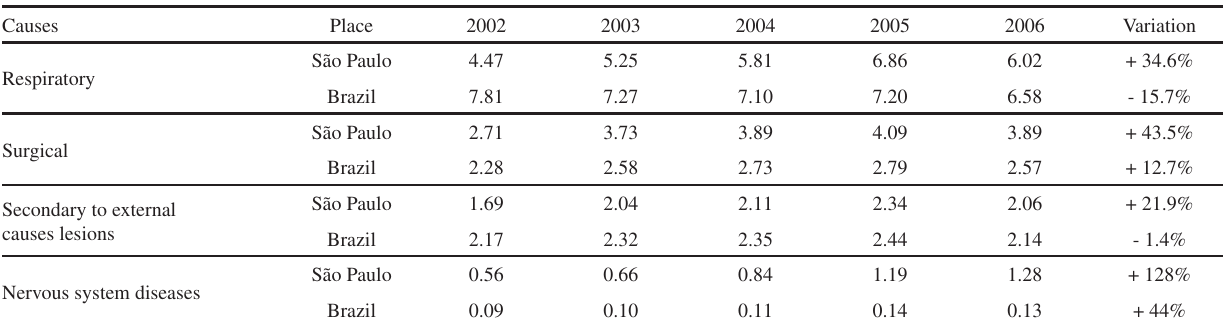
Table 6 - The hospitalization coefficients (per 1,000 children) for the major hospitalization causes in children between five and nine years old - São Paulo and Brazil, 2002 to 2006